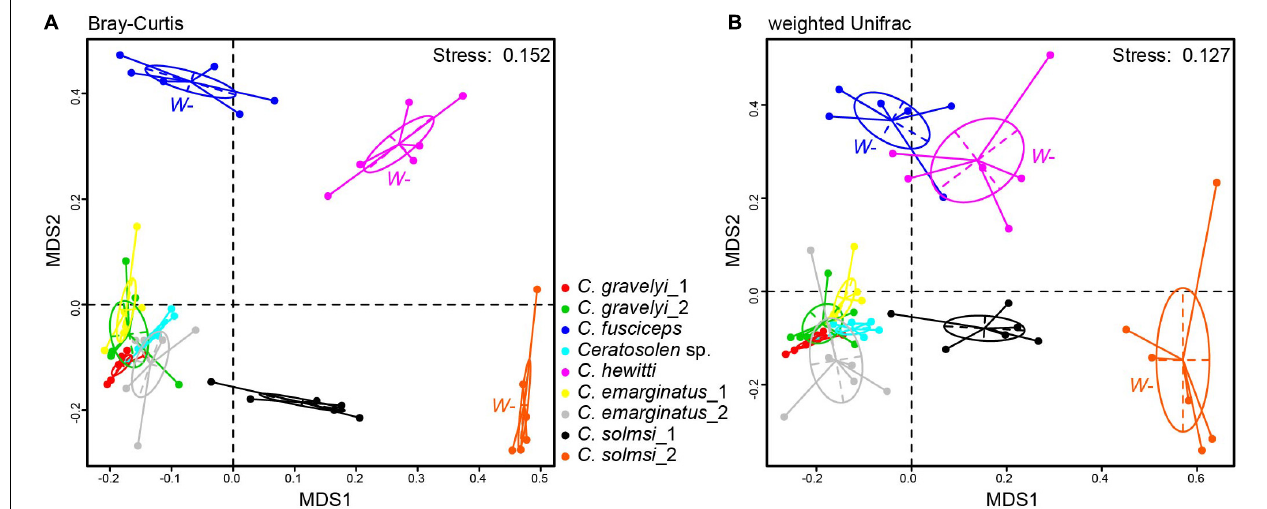
FIGURE 4 | Microbial community structure. NMDS ordinations of fig wasp microbiota based on Bray–Curtis (stress = 0.152) (A) and weighted Unifrac (stress = 0.127) dissimilarity matrices (B) on OTU level. Each dot represents a sample. Fig wasps from the same populations are colored uniformly. Three populations that are not infected with Wolbachia are labeled W –, while the other six populations are infected. Ellipses = 80% confidence